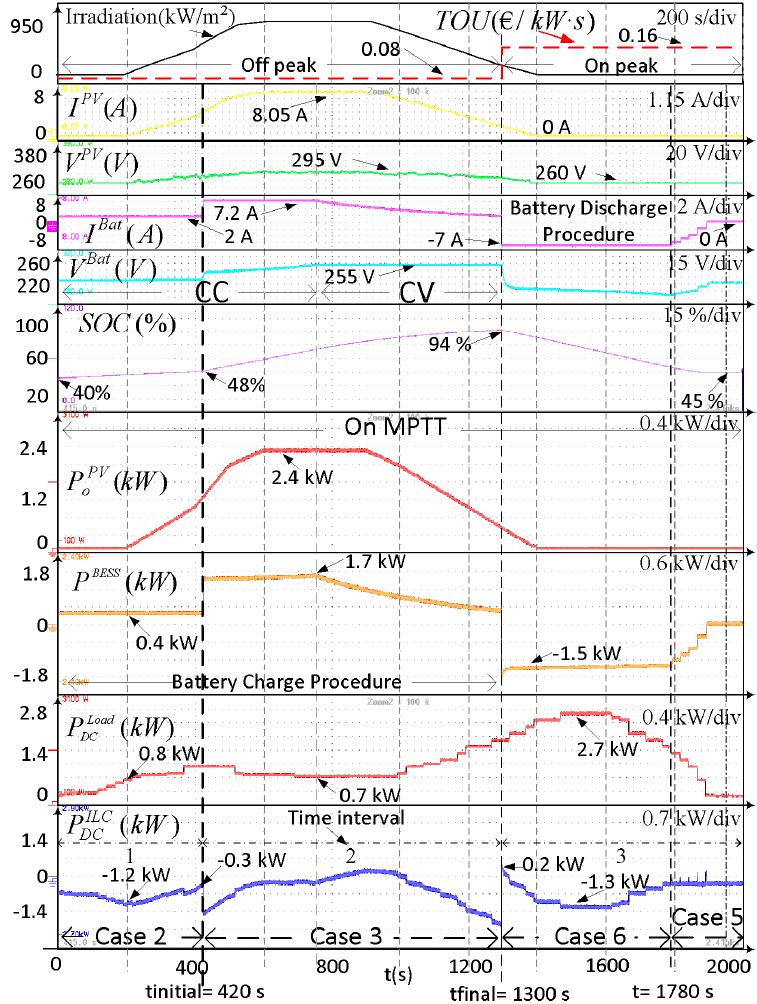
Figure 15. Experiment #2. Experimental results of the power management in the MG.